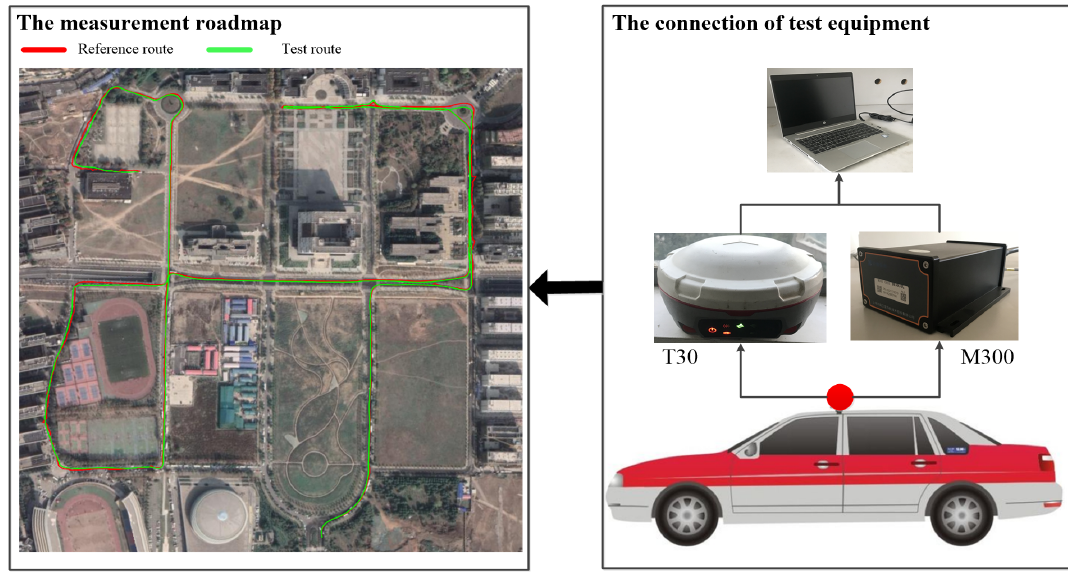
Figure 6. The dynamic experimental